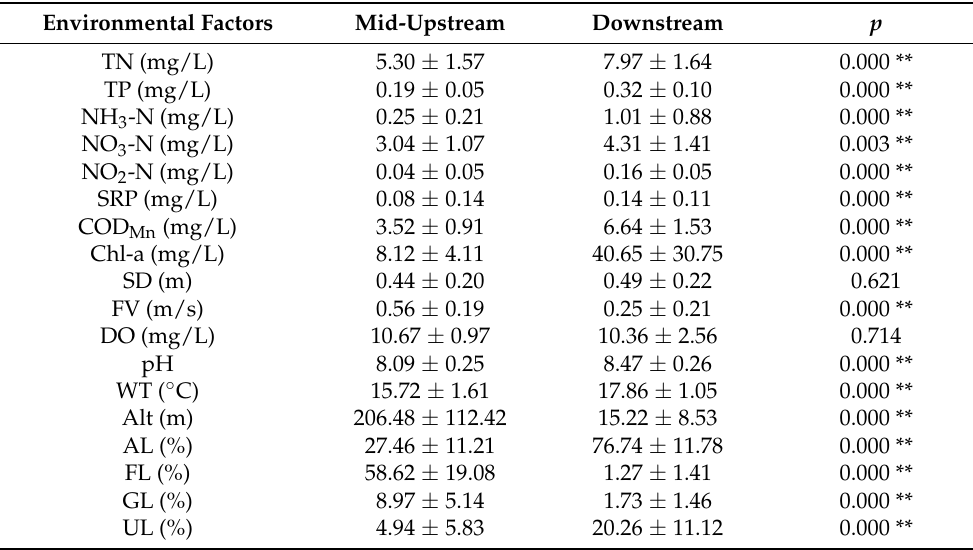
Table 3. The comparison of environmental factors between the middle-upper reaches (Group A) and downstream (Group B) in the Hun River Basin.